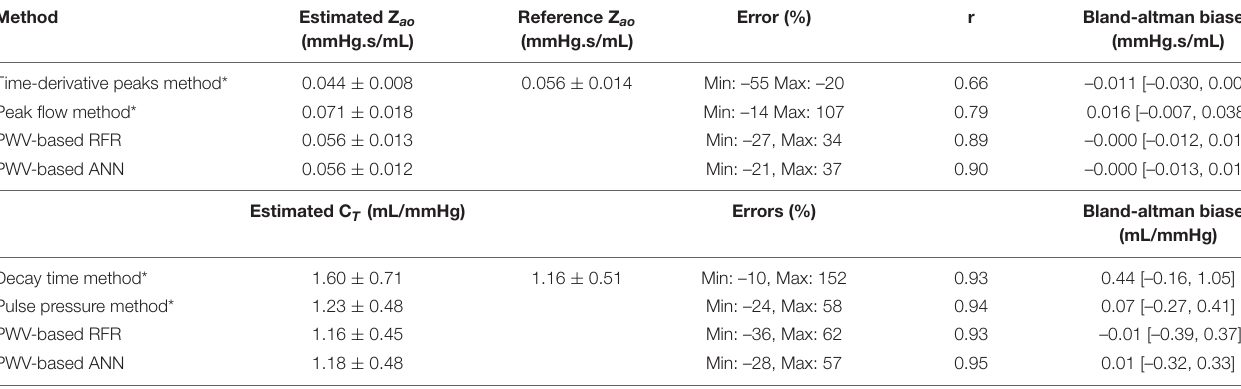
TABLE 6 | Comparison of the proposed ML-based Z ao and C T estimators to prior